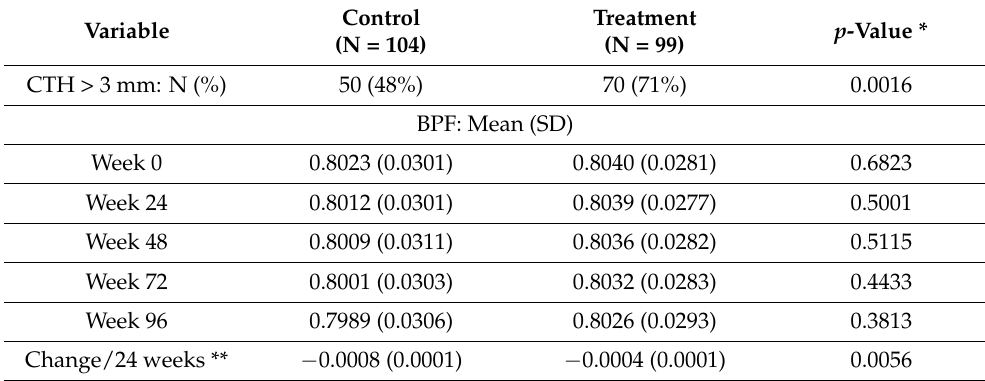
Table 1. Summary Statistics for The Real Data Example.